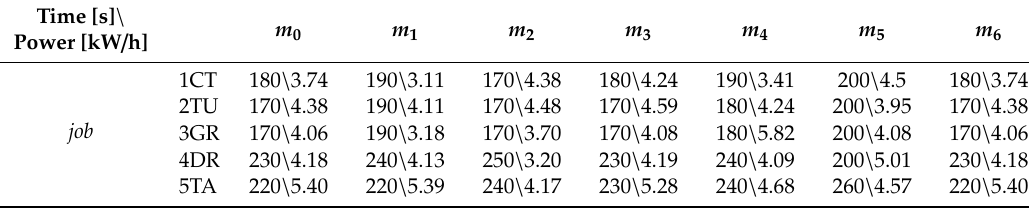
Table 3. The distance between the warehouse and each machine.